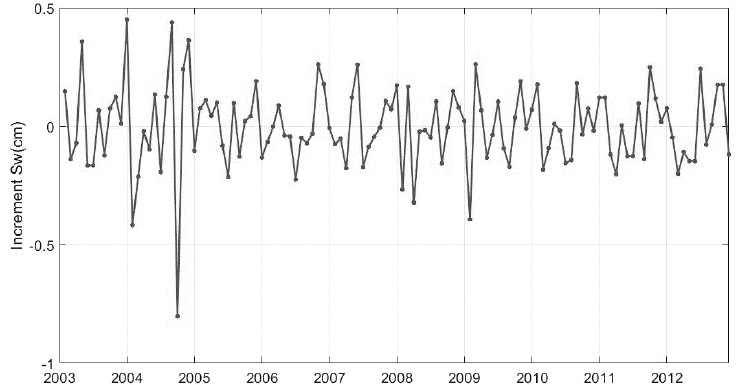
Figure 16. Time series of increment of water storage ( ∆ Sw) obtained from GRACE terrestrial water storage change after subtracting oil contribution.